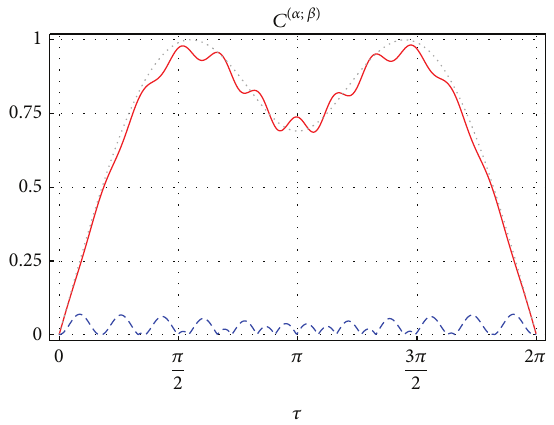
Figure 2: QFT instance (color online). The concurrences 𝐶 ( ] 𝑒 ; ] 𝜇 )